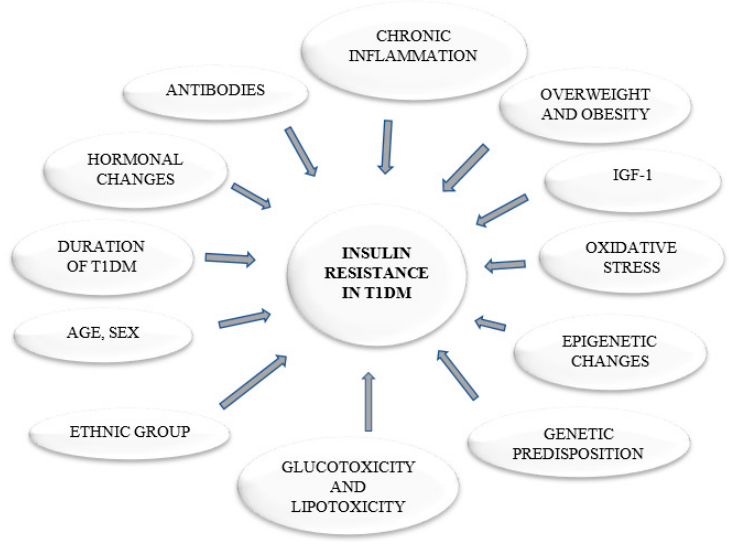
Figure 1. The causes of insulin resistance in type 1 diabetes.